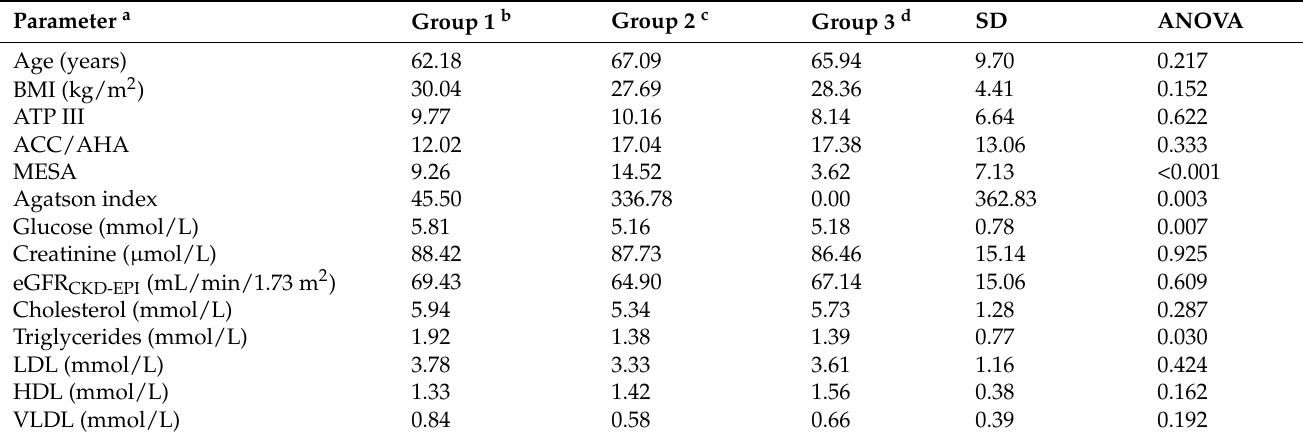
Table 2. Parametric characteristics of patients .